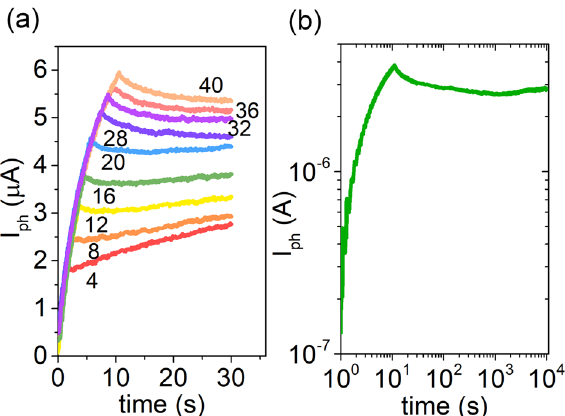
Figure 3. ( a ) Photocurrent across the top graphene layer as function of time for varying number of incident light pulses, wavelength = 405 nm, power = 100 mW, t ON = t OFF = 125 ms. ( b ) Long term potentiation for 10 4 s, with 40 light pulses. V G = 80 V, V TGr = 0.1